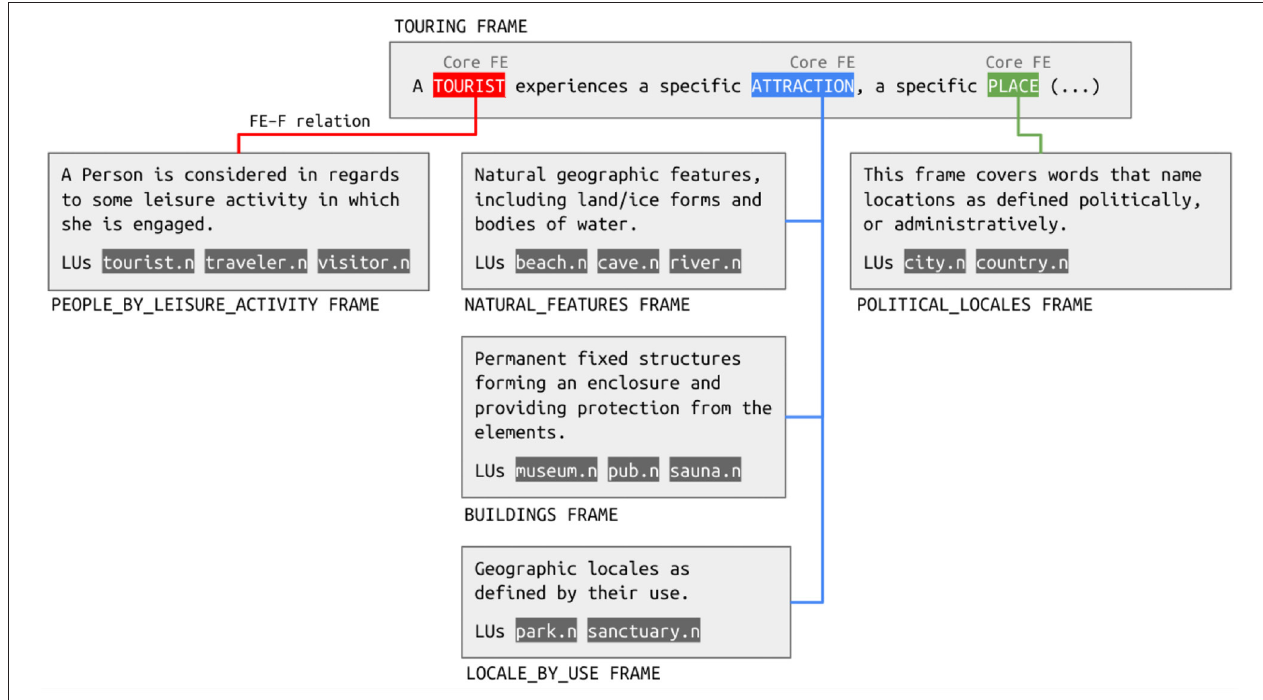
FIGURE 3 | Frame Element-to-Frame relations in the Touring